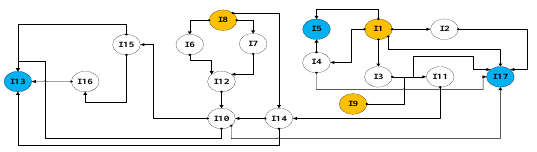
Figure 8 . The interaction dependency network, with independent (yellow) and dependency-only (blue) interactions.